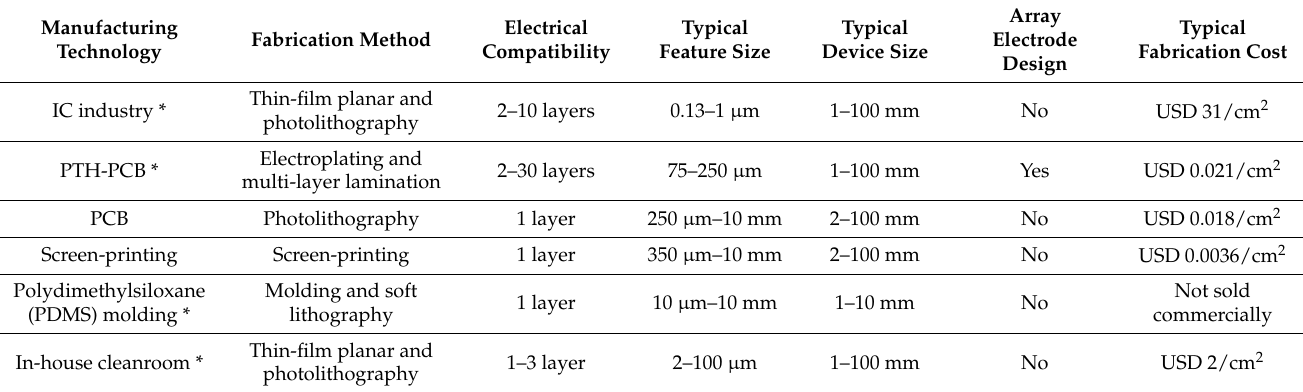
Figure 3. Possible droplet volume according to fabrication techniques. ( a ) R. Malk et al., (2011) [30]; ( b ) Jie Gao et al., (2015) [31]; ( c ) Chunqiao Li et al., (2018) [32]; ( d ) Vandana Jain et al., (2015) [33]; ( e ) M. Yafia et al., (2014) [3]. Table 5. Comparison of integrated circuit (IC), plate-through-hole print circuit board (PTH-PCB), PCB, screen-printing, plastic molding, and in-house cleanroom technologies.